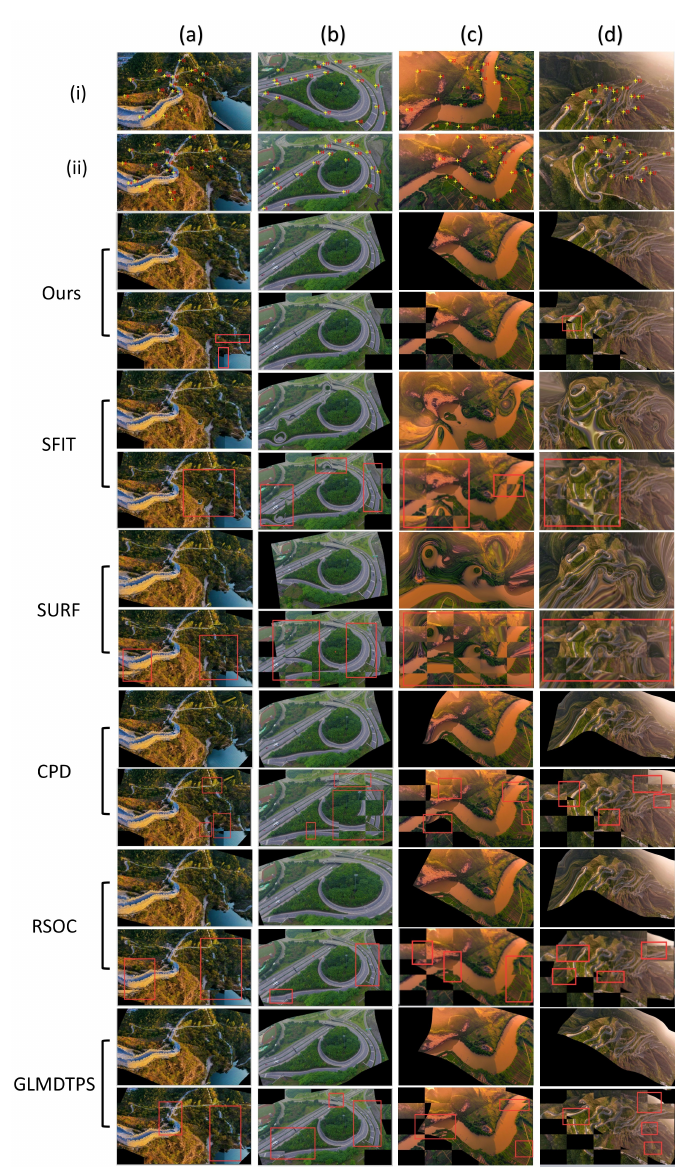
Figure 10. Registration examples on four typical image pairs from dataset (i). The first two rows: the sensed and reference image, with the yellow crosses denoting the landmarks. Rows from the third to the end are the registration results of ours, SIFT, SURF, CPD, RSOC and GLMDTPS. For each method, the registration results are shown using two rows, with the upper row showing the transformed image, and the lower row showing the 5 × 5 checkboard. The registration errors are highlighted using the red